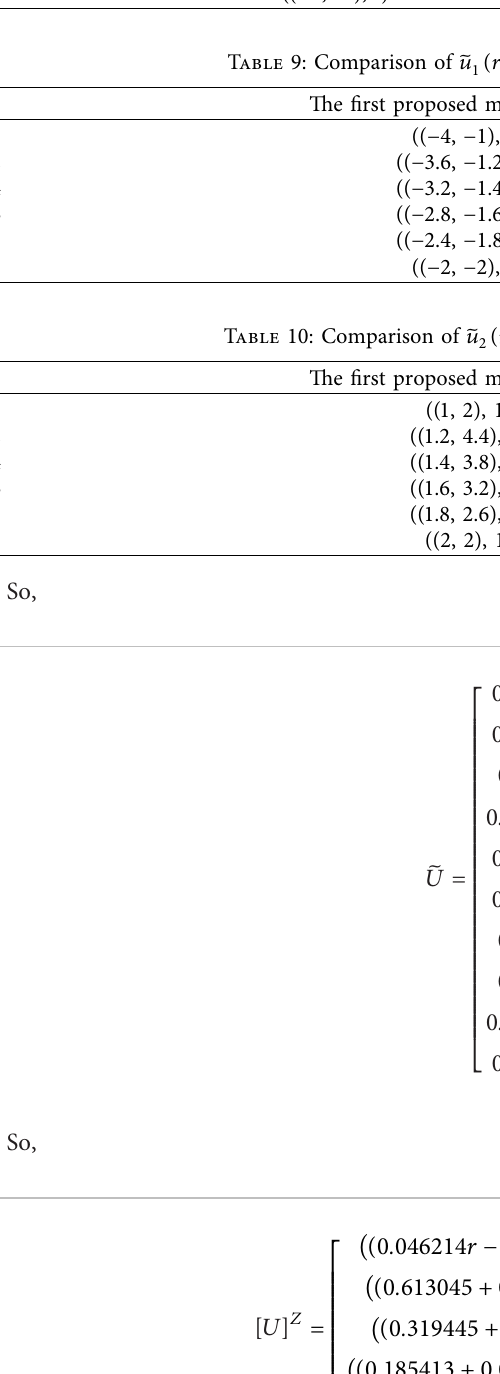
Table 9: Comparison of 􏽥 u